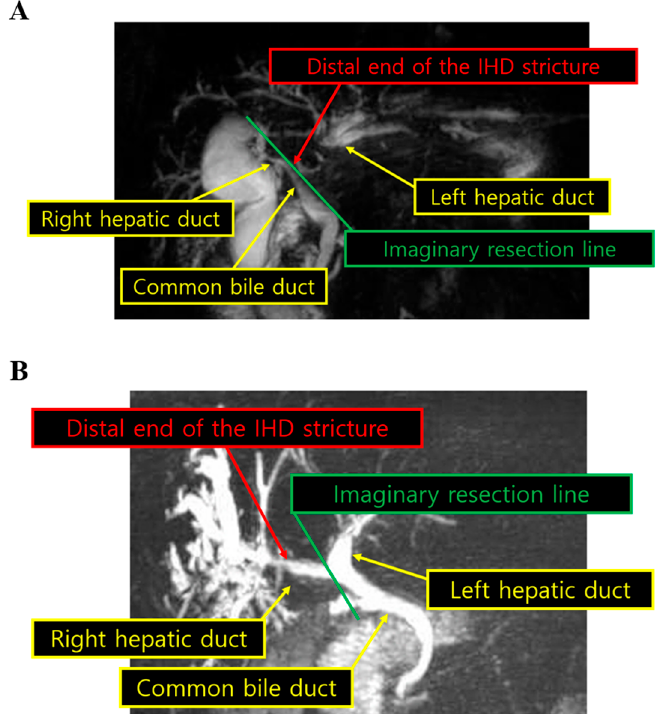
Figure 1. Preoperative magnetic resonance cholangiopancreatography. The proximity to the bifurcation was defined as the distance between the distal end of the stricture and the confluence of the IHD affected by the stricture. The straight line represents imaginary resection line, and we measured the distance between the imaginary resection line and the distal end of the stricture in representative patients undergoing left hemihepatectomy (( A ); distance < 1 cm) and right hemihepatectomy (( B ); distance ≥ 1 cm). IHD intrahepatic duct .